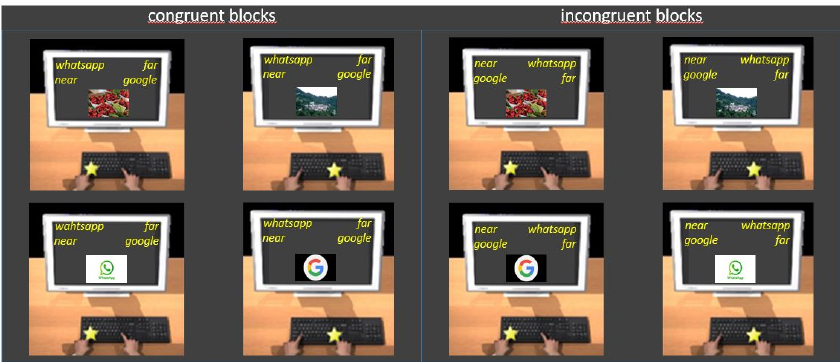
Figure 5. Examples of trials in congruent ( left panel ) and incongruent ( right panel ) blocks of Experiment 4. Participants were asked to press the E key with their left hand when the category to which the image belongs was written at the top left and to press the I key with their right hand when it was written at the top right (see the text for details).